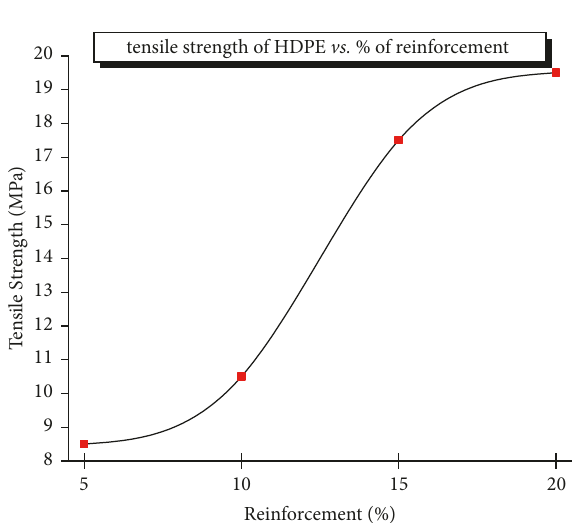
Figure 2: Effect of Al 2 O 3 loading on the tensile strength of HPMC.